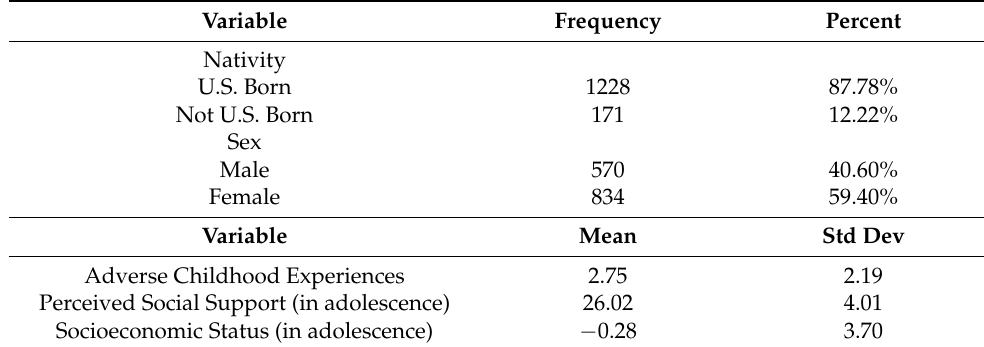
Table 1. Non time-dependent descriptive statistics (N = 1404 participants).